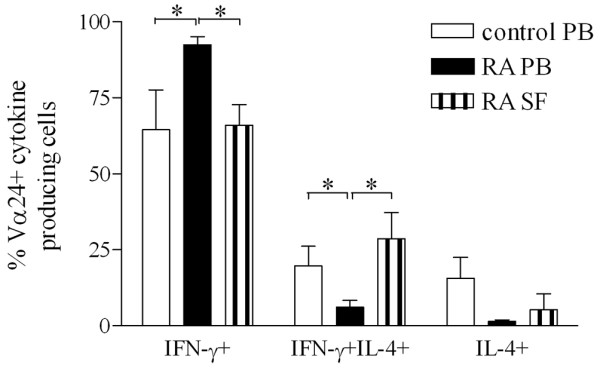
Cytokine profile of α-galactosylceramide (α-GalCer) expanded natural killer T (NKT) cells. Peripheral blood (PB) mononuclear cells (1.5 × 106 cells/well) from five healthy control individuals and five RA patients as well as synovial fluid (SF) mononuclear cells from five RA patients were stimulated with α-GalCer and re-stimulated on day 7 with autologous, α-GalCer pulsed, irradiated PB mononuclear cells in the presence of 2 U/ml IL-2. The cytokine profile was analyzed by intracellular staining and gating on the Vα24+ subset. Error bars indicate standard error of the mean. *P < 0.05.